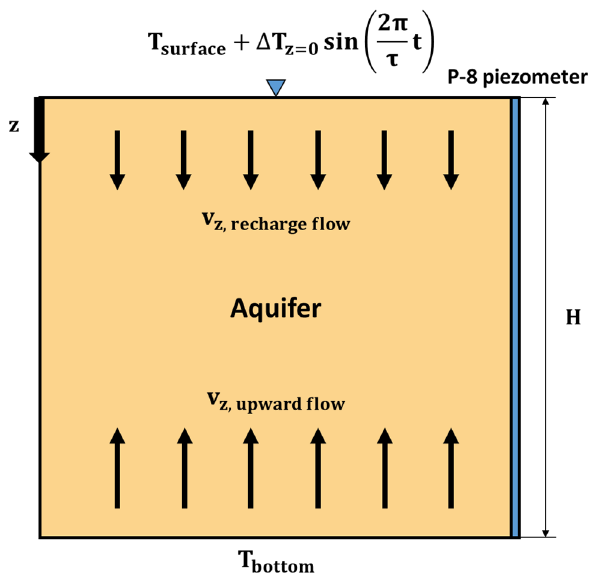
Figure 8. Physical scheme and boundary conditions of the 1D problem.